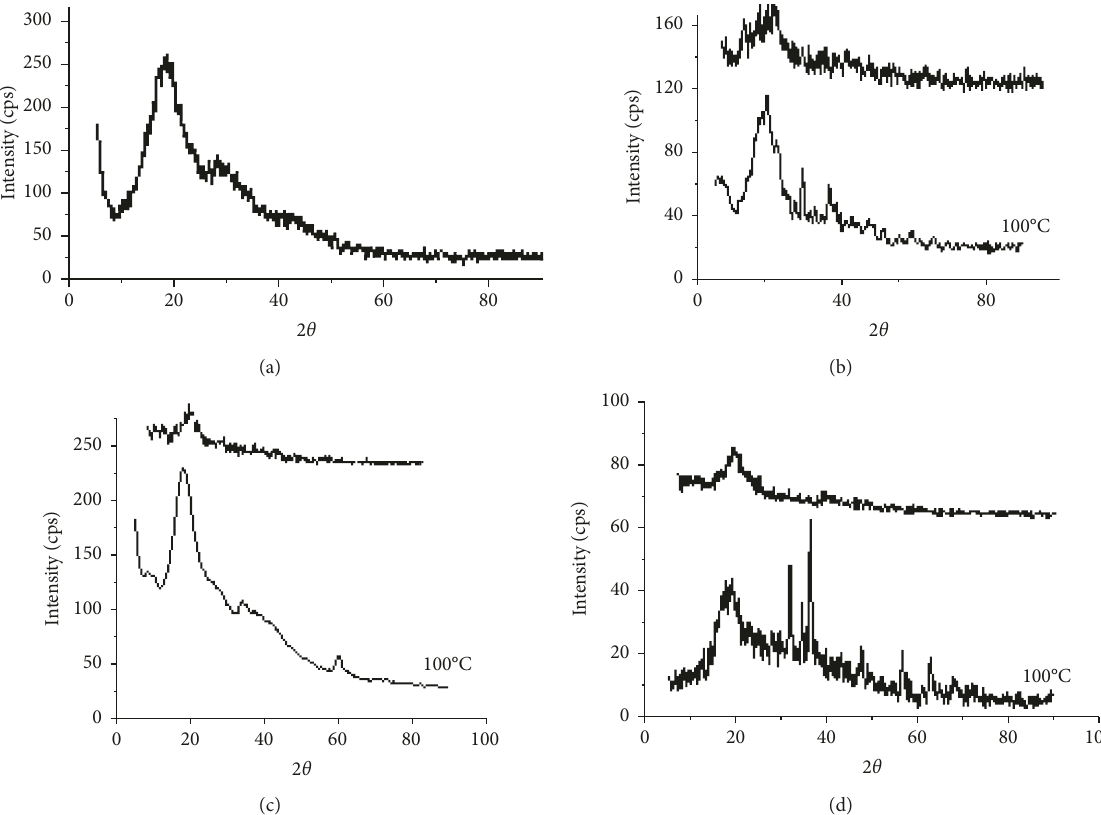
Figure 7: XRD patterns of (a) poly(DEAMSt0.49-co-BMA), (b) poly(DEAMSt0.49-co-BMA)-Co, (c) poly(DEAMSt0.49-co-BMA)-Ni, and (d) poly(DEAMSt0.49-co-BMA)-Zn.